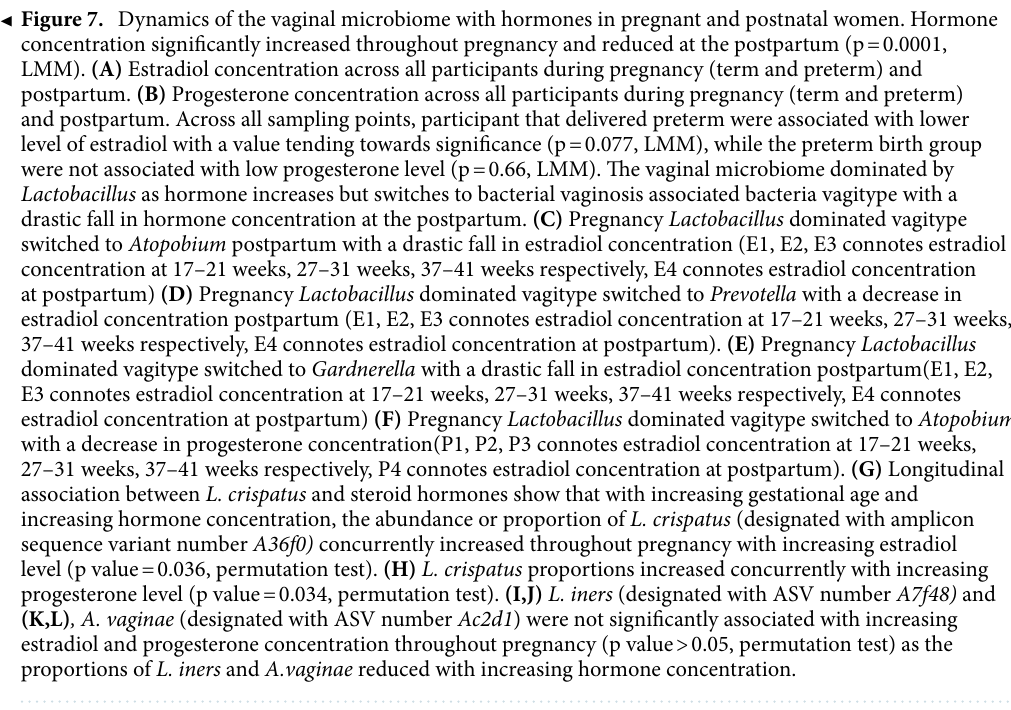
Figure 7. Dynamics of the vaginal microbiome with hormones in pregnant and postnatal women. Hormone concentration significantly increased throughout pregnancy and reduced at the postpartum (p = 0.0001, LMM). (A) Estradiol concentration across all participants during pregnancy (term and preterm) and postpartum. (B) Progesterone concentration across all participants during pregnancy (term and preterm) and postpartum. Across all sampling points, participant that delivered preterm were associated with lower level of estradiol with a value tending towards significance (p = 0.077, LMM), while the preterm birth group were not associated with low progesterone level (p = 0.66, LMM). The vaginal microbiome dominated by Lactobacillus as hormone increases but switches to bacterial vaginosis associated bacteria vagitype with a drastic fall in hormone concentration at the postpartum. (C) Pregnancy Lactobacillus dominated vagitype switched to Atopobium postpartum with a drastic fall in estradiol concentration (E1, E2, E3 connotes estradiol concentration at 17–21 weeks, 27–31 weeks, 37–41 weeks respectively, E4 connotes estradiol concentration at postpartum) (D) Pregnancy Lactobacillus dominated vagitype switched to Prevotella with a decrease in estradiol concentration postpartum (E1, E2, E3 connotes estradiol concentration at 17–21 weeks, 27–31 weeks, 37–41 weeks respectively, E4 connotes estradiol concentration at postpartum). (E) Pregnancy Lactobacillus dominated vagitype switched to Gardnerella with a drastic fall in estradiol concentration postpartum(E1, E2, E3 connotes estradiol concentration at 17–21 weeks, 27–31 weeks, 37–41 weeks respectively, E4 connotes estradiol concentration at postpartum) (F) Pregnancy Lactobacillus dominated vagitype switched to Atopobium with a decrease in progesterone concentration(P1, P2, P3 connotes estradiol concentration at 17–21 weeks, 27–31 weeks, 37–41 weeks respectively, P4 connotes estradiol concentration at postpartum). (G) Longitudinal association between L. crispatus and steroid hormones show that with increasing gestational age and increasing hormone concentration, the abundance or proportion of L. crispatus (designated with amplicon sequence variant number A36f0) concurrently increased throughout pregnancy with increasing estradiol level (p value = 0.036, permutation test). (H) L. crispatus proportions increased concurrently with increasing progesterone level (p value = 0.034, permutation test). (I,J) L. iners (designated with ASV number A7f48) and (K,L) , A. vaginae (designated with ASV number Ac2d1 ) were not significantly associated with increasing estradiol and progesterone concentration throughout pregnancy (p value > 0.05, permutation test) as the proportions of L. iners and A.vaginae reduced with increasing